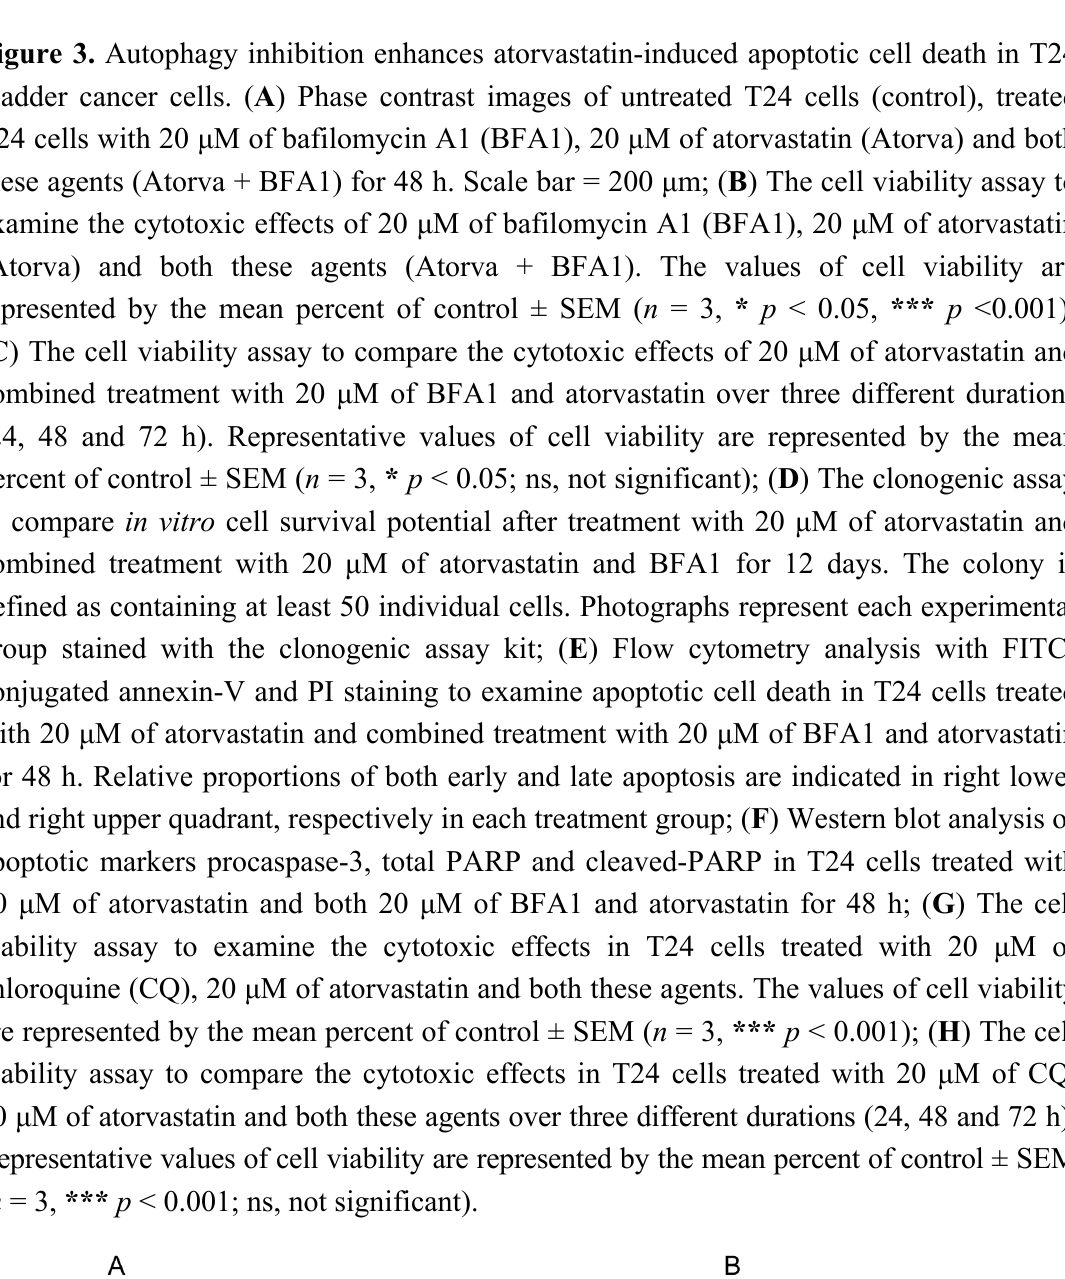
Figure 3. Autophagy inhibition enhances atorvastatin-induced apoptotic cell death in T24 bladder cancer cells. ( A ) Phase contrast images of untreated T24 cells (control), treated T24 cells with 20 μ M of bafilomycin A1 (BFA1), 20 μ M of atorvastatin (Atorva) and both these agents (Atorva + BFA1) for 48 h. Scale bar = 200 μ m; ( B ) The cell viability assay